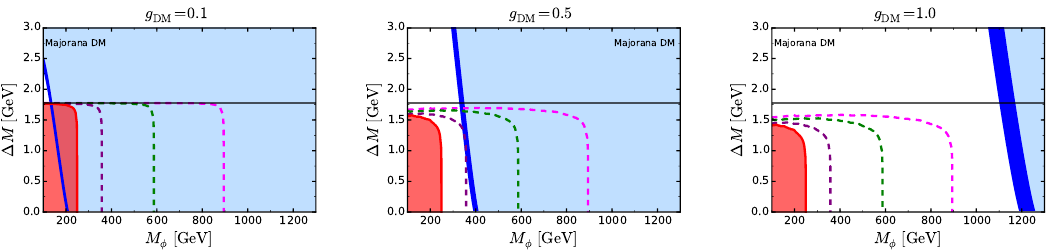
Figure 6 . The co-annihilation strip and collider searches for Majorana DM and a long-lived charged scalar in the Simpli(cid:12)ed Model 1a. The dark-blue region satis(cid:12)es the correct dark matter relic abundance within 3 (cid:27) , the light-blue region overproduces the dark matter energy density. The horizontal black line indicates the mass of the (cid:28) lepton. The region coloured in red corresponds to current HSCP limits at the LHC for center-of-mass energy of 8 TeV and 18.8 fb (cid:0) 1 . The three dashed lines (purple, green and magenta) correspond to our projections for center-of-mass energy of 13 TeV and 30, 300 and 3000 fb (cid:0) 1 of integrated luminosity